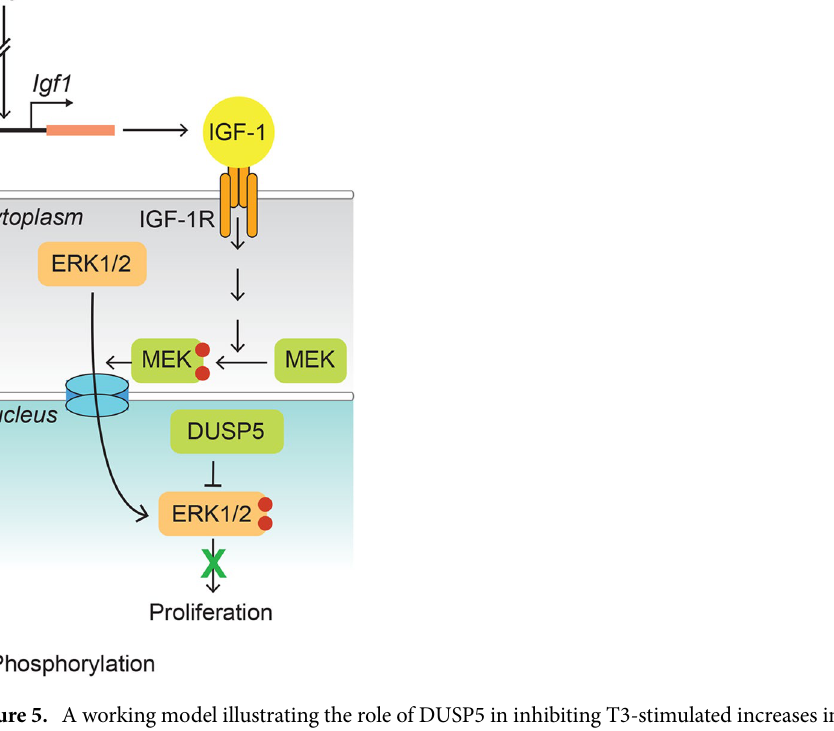
Figure 5. A working model illustrating the role of DUSP5 in inhibiting T3-stimulated increases in nuclear phosphorylated ERK1/2 in cardiomyocytes of the post-P6 LV